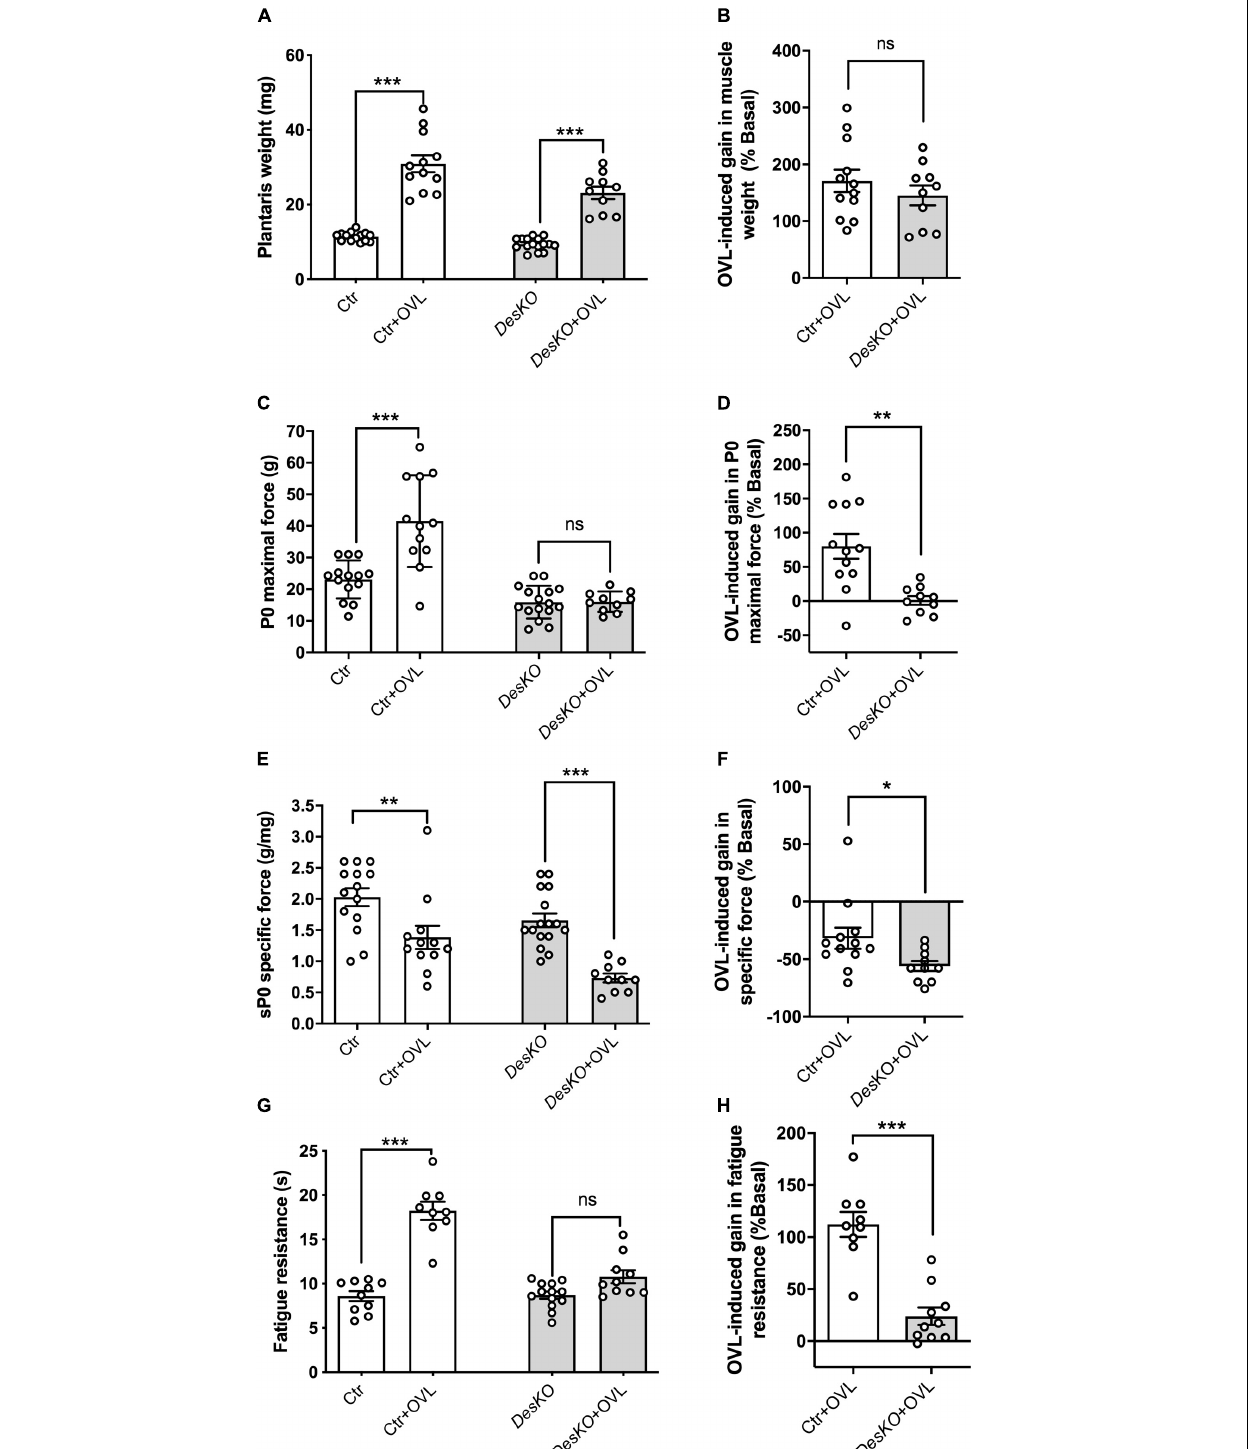
Frontiers in Cell and Developmental Biology |